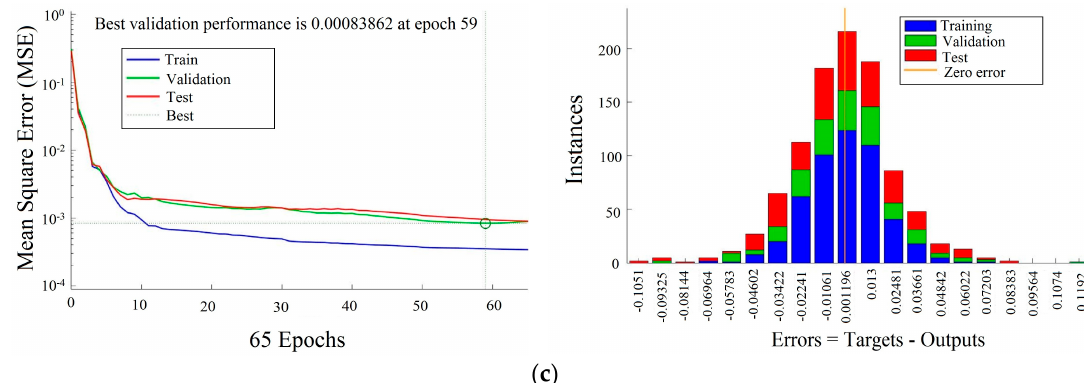
Figure 5. Error diagrams and epoch performances of network training for three data division schemes: ( a ) 60%-20%-20%; ( b ) 55%-20%-25%; ( c ) 50%-20%-30%. The best validation performances of three cases stopped below 80 epochs corresponding with the minimum errors achievement. As the percentage of testing data increases, the density of errors in testing also raises correspondingly.